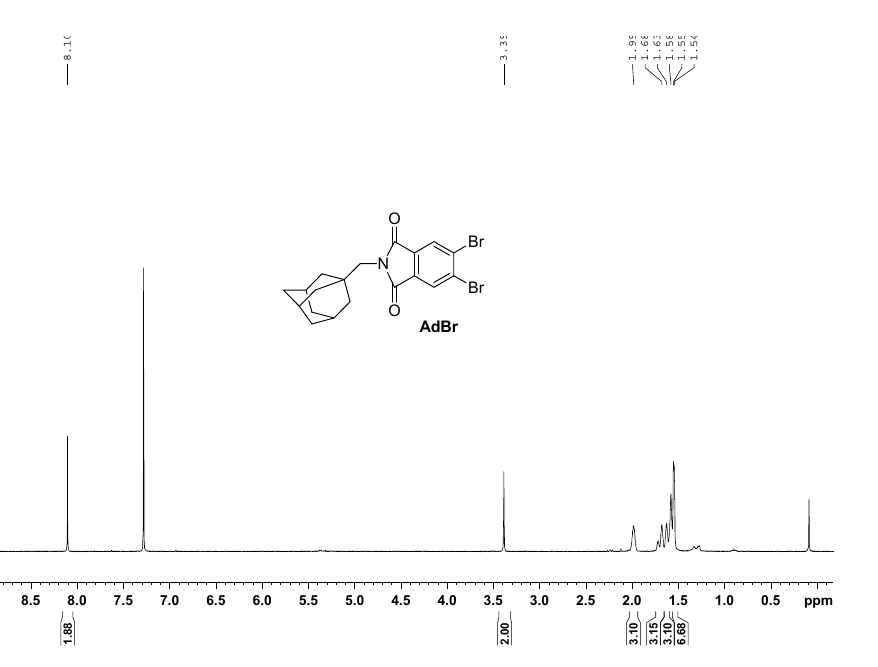
Figure 1. 1 H-NMR (CDCl 3 ) spectrum of AdBr. 13 C-NMR further proved the synthesis of AdBr by showing a characteristic peak of carbonyl carbon at 167.18 ppm and methylene carbon at 50.16 ppm (Figure 2). The FTIR spectrum of AdBr (Figure 3) indicated a characteristic carbonyl peak at 1706 cm − 1 and stronger C-H stretching at 2904 cm − 1 and 2830 cm − 1 compared to XyBr and AcidBr . The stronger C-H stretching in AdBr relative to its precursors indicates the successful functionalization with the adamantane moiety which has significant aliphatic C-H bonds.